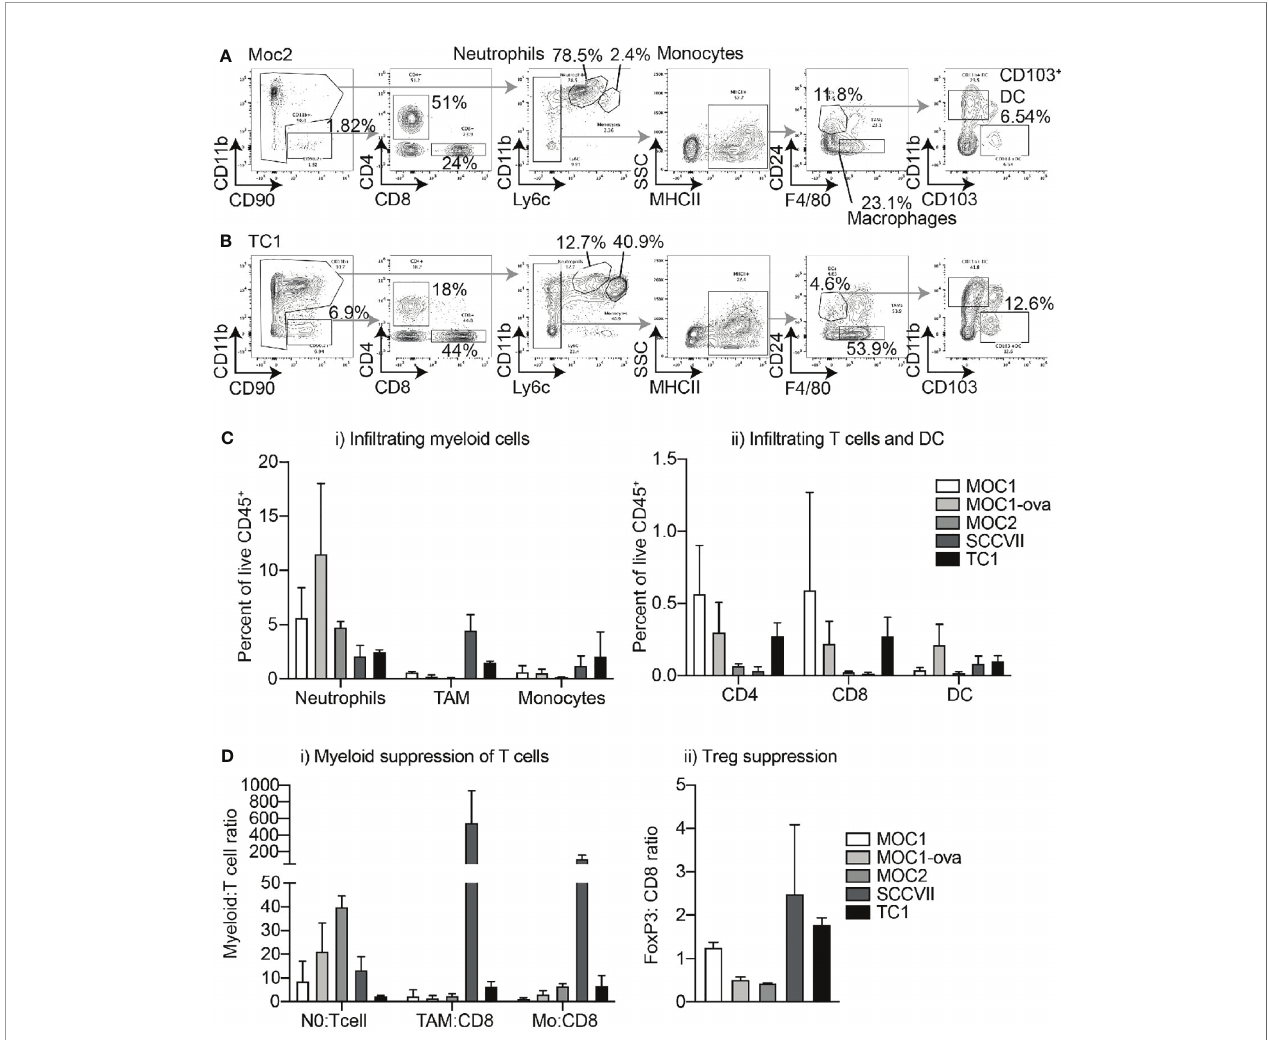
FIGURE 2 | Differential immune in fi ltration across murine HNSCC tumor models by fl ow cytometry. Tumors were established in immune-competent animals and tumors were harvested for analysis of in fi ltrating immune cells by fl ow cytometry. Representative fl ow cytometry of (A) Moc2 and (B) TC1 showing gating strategies to identify individual cell types in two contrasting tumors. Subgating is shown using gray arrows, key populations are identi fi ed. (C) Quanti fi ed fl ow cytometry across multiple tumors for key populations of i) myeloid cells and ii) T cells and DC. (D) Relative levels of immune cells from Figures 1 and 2 to show relative levels of i) myeloid cells and ii) Tregs to T cells to identify potential suppression patterns. 3-4 individual tumors per tumor type were